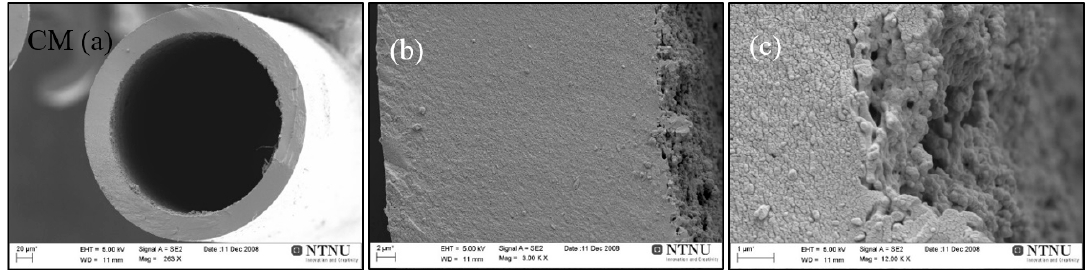
Figure 7. SEM images of carbon hollow fiber membrane (CM), ( a ) cross section, ( b ) wall magnified, and ( c ) inner edge of the wall magnified.